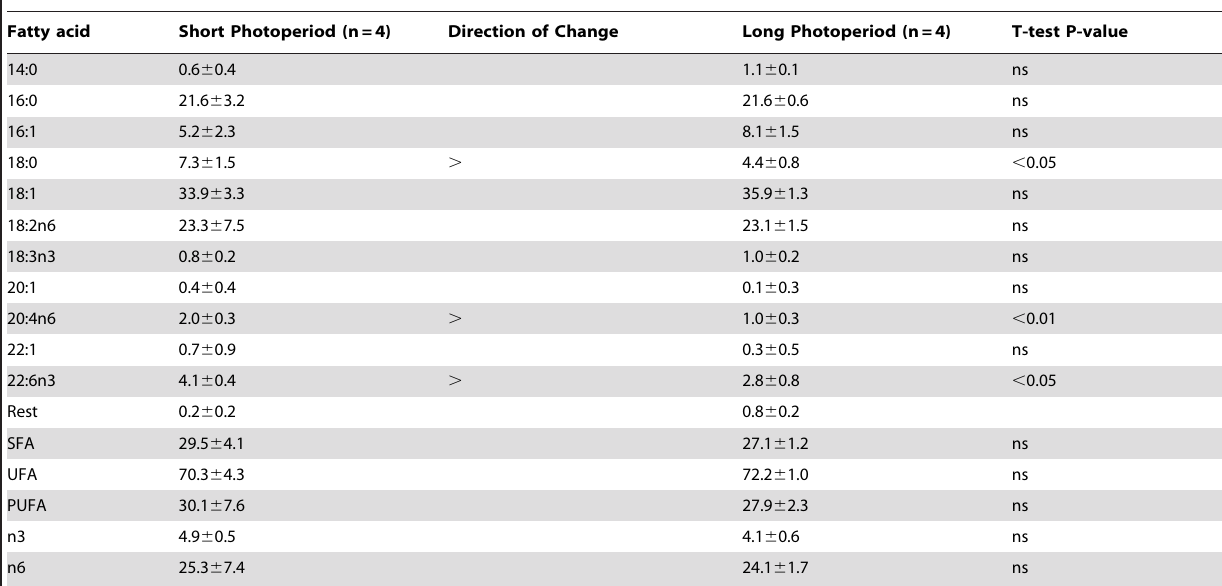
Table 5. Percent fatty acid composition ( . 0.1%) of leg muscle.